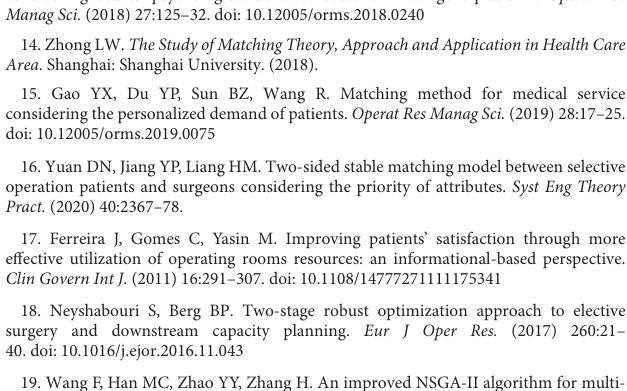
matching between applicants and positions with tenant s. Syst Eng Theory